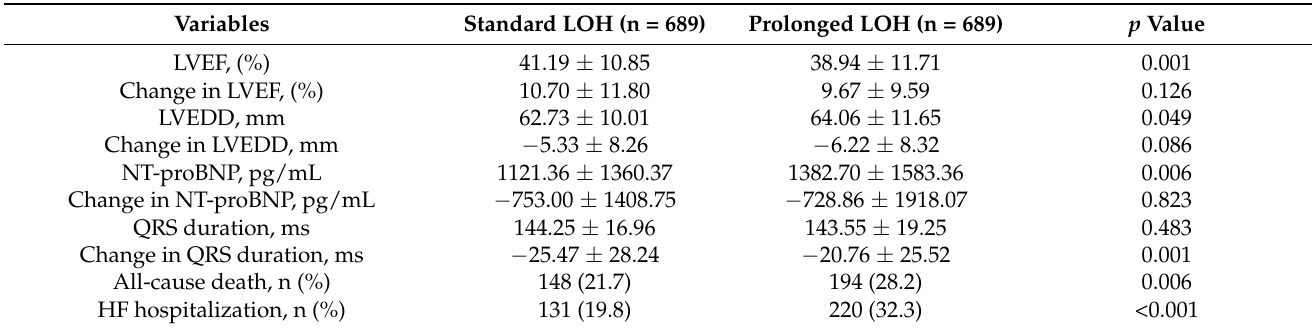
Table 2. Comparison of cardiac function at follow-up and outcomes between matched groups using GenMatch matching.